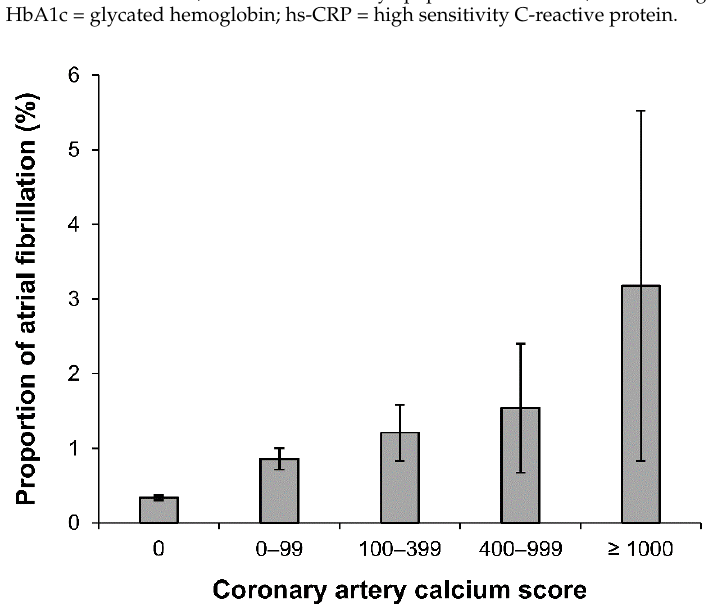
Figure 3. Proportion of atrial fibrillation based on coronary artery calcium score category. Error bar: 95% confidence interval.